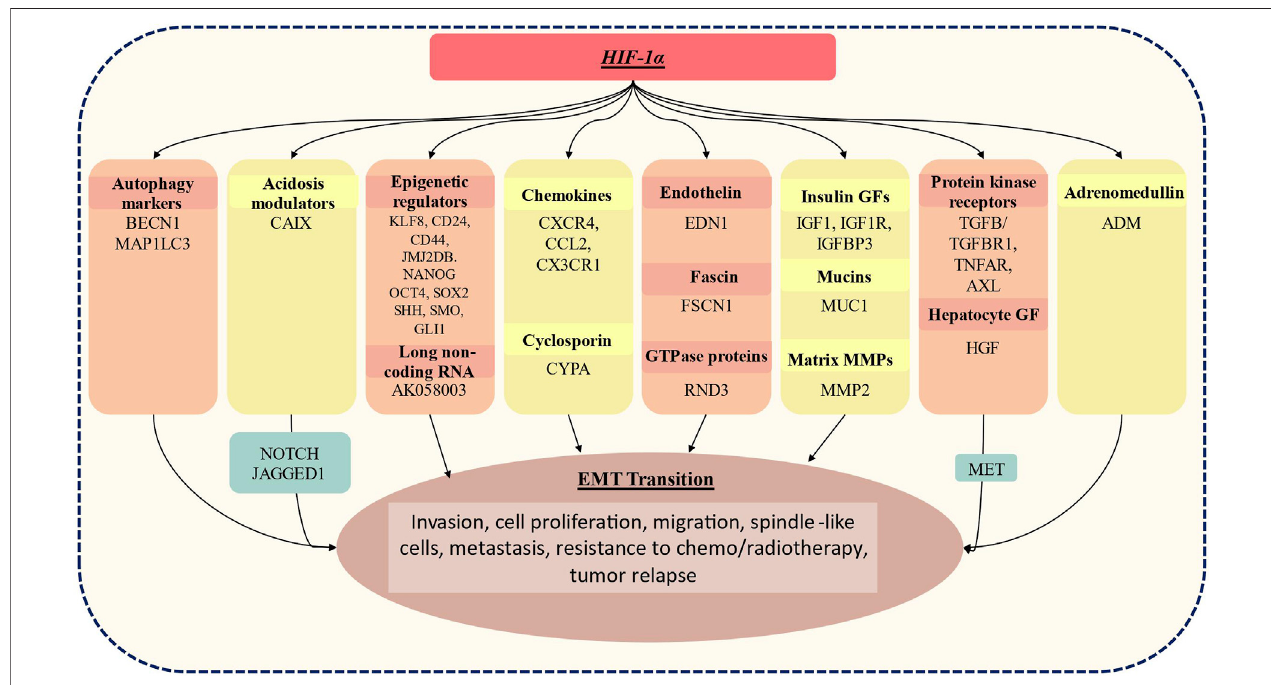
FIGURE2| GeneswhoseexpressionhasbeenlinkedtotheactivationstatusofHIF-1 α ,resultinginEMT.HIF-1 α inducesexpression ofBECN1,MAP1lC3whichis an autophagy marker; CAIX, acidosis modulators: epigenetic regulators: KLF8, cell surface glycoproteins (CD24, CD44), JMJ2DB which is lysine-speci fi c demethylase jumonji domain, Nanog homeobox (NANOG), Octamer-binding transcription factor 4(OCT4), SRY sex-determining region Y-box (SOX2), sonic hedgehog (SHH), smoothened frizzled class receptor (SMO), GLI family zinc fi nger 1 (GLI1); AK058003- long non-coding RNA; multiple chemokines: CXCR4, CCL2, CCR7, CX3CR1; cyclosporin bind protein cyclophilin A (CYPA); endothelins: EDN1 (endothelin1; fascins: fascin actin-bundling protein 1(FSCN1); GTPase proteins: Rho family GTPase 3 (RND3): insulin growth factor which includes IGF1, IGF1R, IGFBP3; mucin 1, cell surface-associated (MUC1); matrix metalloproteinase; MMP2, protein kinases receptors including TGFb/TGFBR1, TNFAR, AXL; hepatocyte growth factor (HGF) which is a ligand of MET tyrosine kinase receptor; adrenomedullin (ADM). These activated genes are known to play a crucial role in EMT transition and result in increased invasiveness, cellular proliferation, migration, spindle-like cellular appearance, resistance to chemo/radiotherapy and tumor